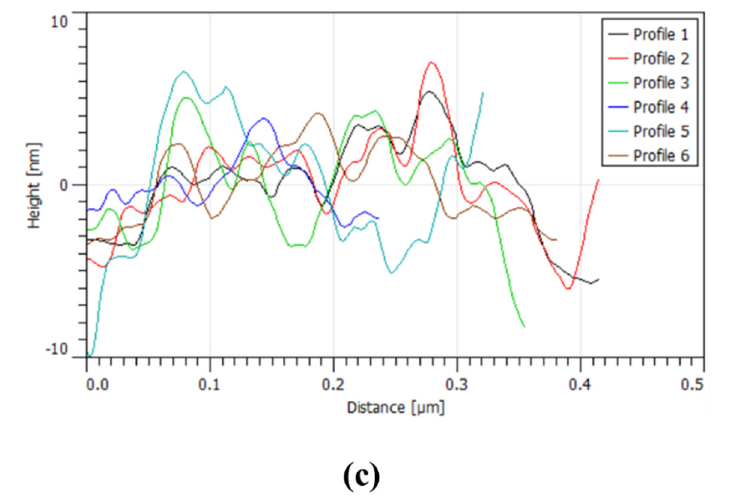
Figure 3. ( a ) Raman spectra of GO, including their corresponding band intensities as an inset, ( b ) AFM height image of GO sheets, and ( c ) AFM section profiles of GO sheets analyzed at different areas.